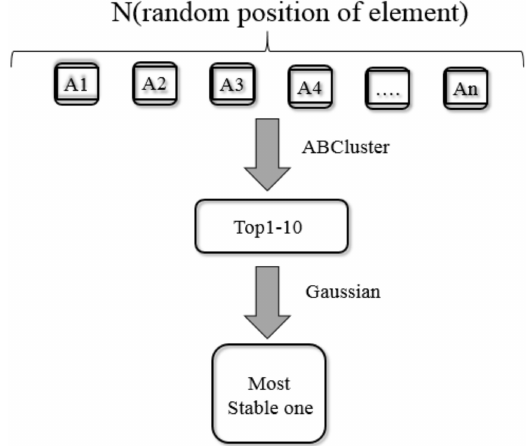
Figure 10. Process for selecting most stable cluster designed